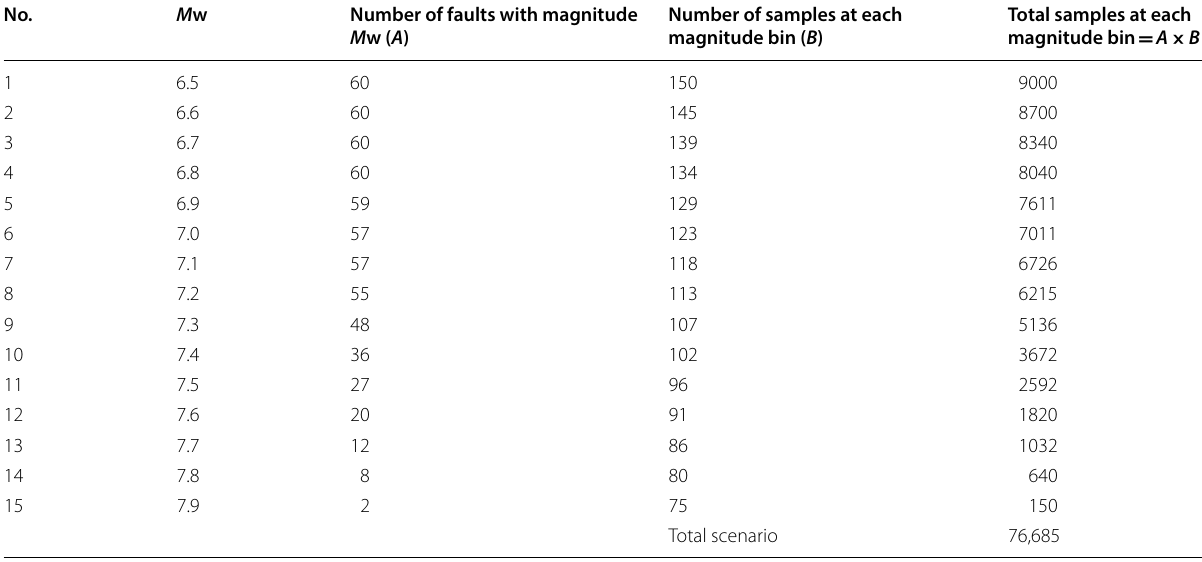
Table 1 Calculation of total number of samples No. M w Number of faults with magnitude